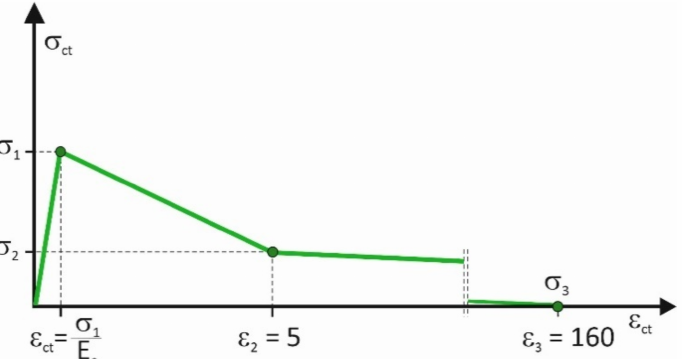
Figure 10. Assumptions of the final material model used in the numerical simulation. The stress at breakpoint of the linear material model ( σ 2 ) was dependent on the residual flexural tensile strength determined for the CMOD equal to 2.5 mm (f R.3 ). The value had to be limited to the 38% of its value and was derived from the equation